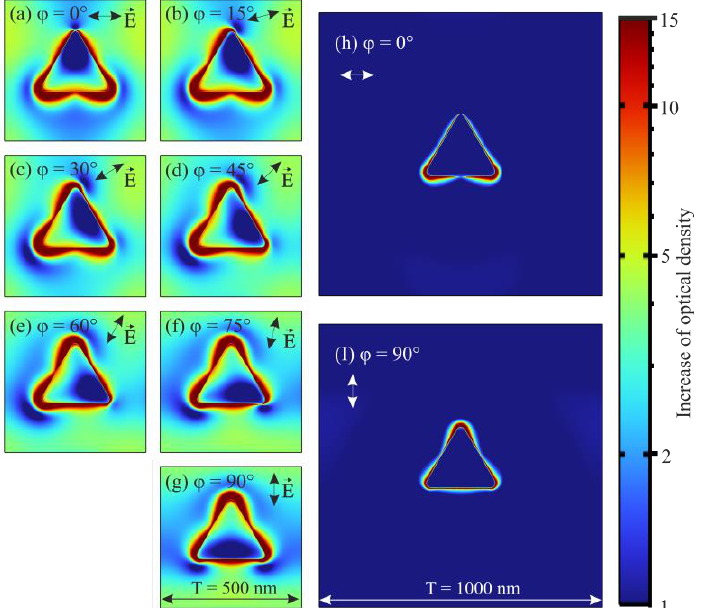
Figure 5. Calculated optical radiation amplification distribution in the layer of 2D WSe 2 films for plasmonic structures at the incident radiation wavelength λ = 635 nm ( a – g ) for the created photodetectors with period T = 500 nm, ( h , i ) for photodetectors with doubled spacing between them.